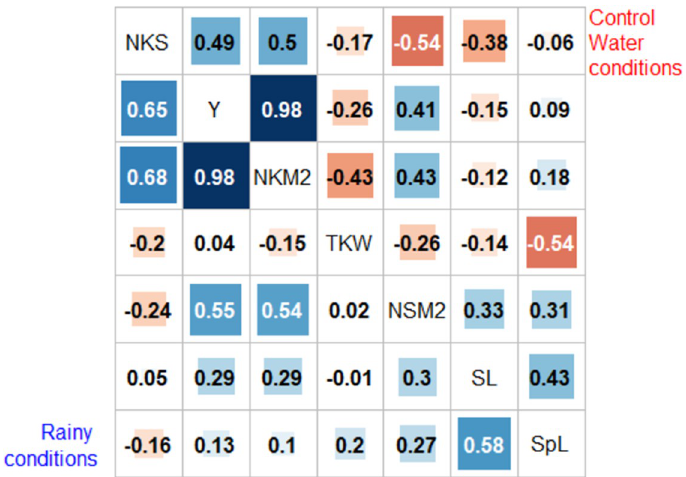
Fig 2. Pairwise Pearson correlation coefficients (r) between functional traits for the 48 mixtures under controlled water deficit conditions (above the median) and the 48 mixtures under rain-fed conditions (below the median). Positive correlations are in blue and negative in red. The darker and larger the square, the higher the correlation between traits. Traits have been clustered according to the hclus procedure of the corrplot R package function. SL: Stem length in cm, SpL: Spike length in cm, NSM2: Number of spikes per m 2 , NKS: Number of kernels per spike, NKM2: Number of kernels per m 2 , TKW: Thousand kernel weight in g, Y: Yield in gr/m 2 . https://doi.org/10.1371/journal.pone.0276223.g002 Association with diversity (GWDA). From the 31K SNPs considered, 211 showed a sig- nificant signal of association involving 6 traits. These 211 SNPs were grouped in 30 HE-QTLs on Y, NKS, NKM2, TKW, SL and SpL (S2 Table). It is striking to see that the number of traits involved in the associations with SNP diversity is higher than in GWFA. To ascertain that these associations with HE were not due to the overfitting of a simple linear regression based on F, we compared by the anova function of R, the HE and F models for the 30 HE-QTLs, (HE vs. F test) with a significance threshold of 0.001 (i.e., 0.05/30) or a–log10(PValue) = 2.78. Four HE-QTLs were left significantly more associated with HE than with F (Table 2): one HE-QTL associated with the NKM2 (–log10(PValue(HE vs F)) = 3.96) on the chr 1B, with a negative effect of HE; one HE-QTL for the NKS (–log10(PValue(HE vs F)) = 4.99) on the chr 1B with a negative effect (Fig 3), who is the same HE-QTL found for the NKM2; one HE-QTL for the TKW (–log10 (PValue(HE vs F)) = 3.19) on the chr 4A, with a positive effect (Fig 4) and one HE-QTL for SpL (–log10(PValue(HE vs F)) = 3.21) on the chr 3B, with a positive effect. For the 26 others